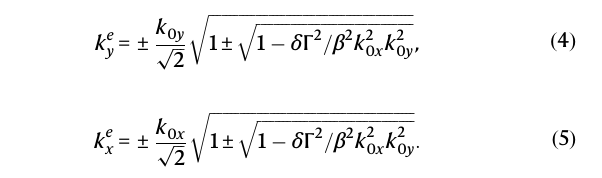
Fig.2e,h.Fermiarcsconnecttoformaclosedlineoftrivialdegeneracy. It is not a ring of exceptional points reported in 29 , because the whole line.